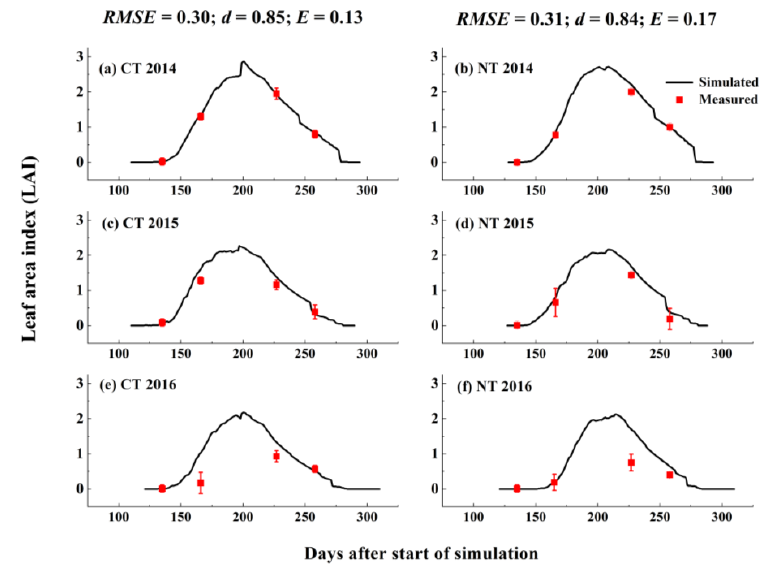
Figure 4. Measured and simulated maize LAI for CT and NT during 2014‒2016.